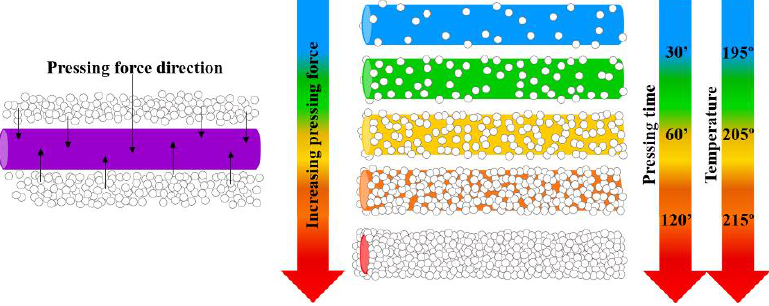
Figure 1. Schematic influence of the synthesis parameters on the final bioceramic coating.